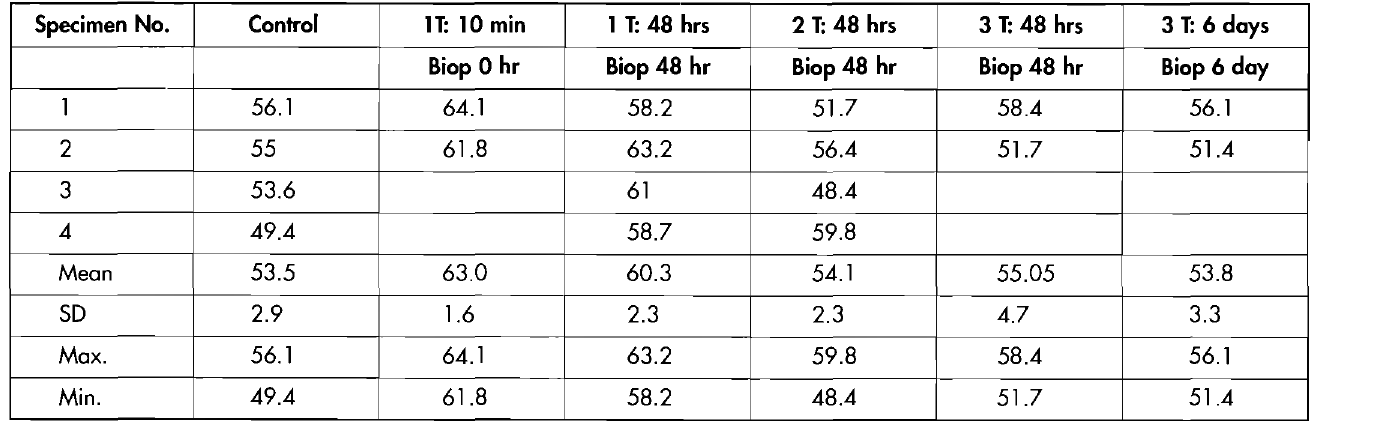
Table 1: Mean morphometric data of individual specimens, and the mean and standard deviation of each group of biopsies expressed in pm, from biopsies taken after 1 (1 T), 2 (2 T) and 3 (3 T) treatments. Specimen No.